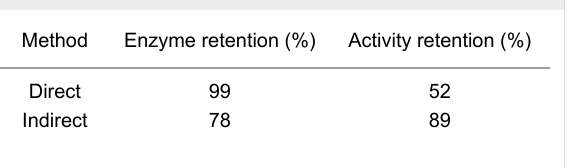
Table 1: Comparison of direct and indirect